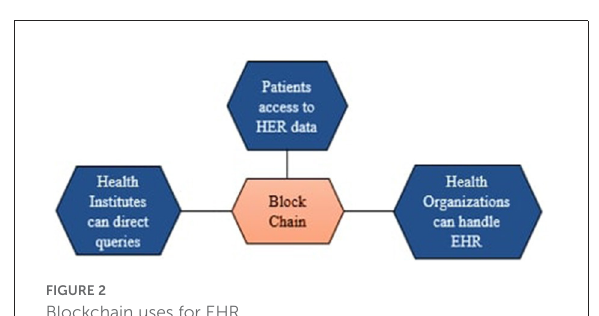
FIGURE2 Blockchain uses for